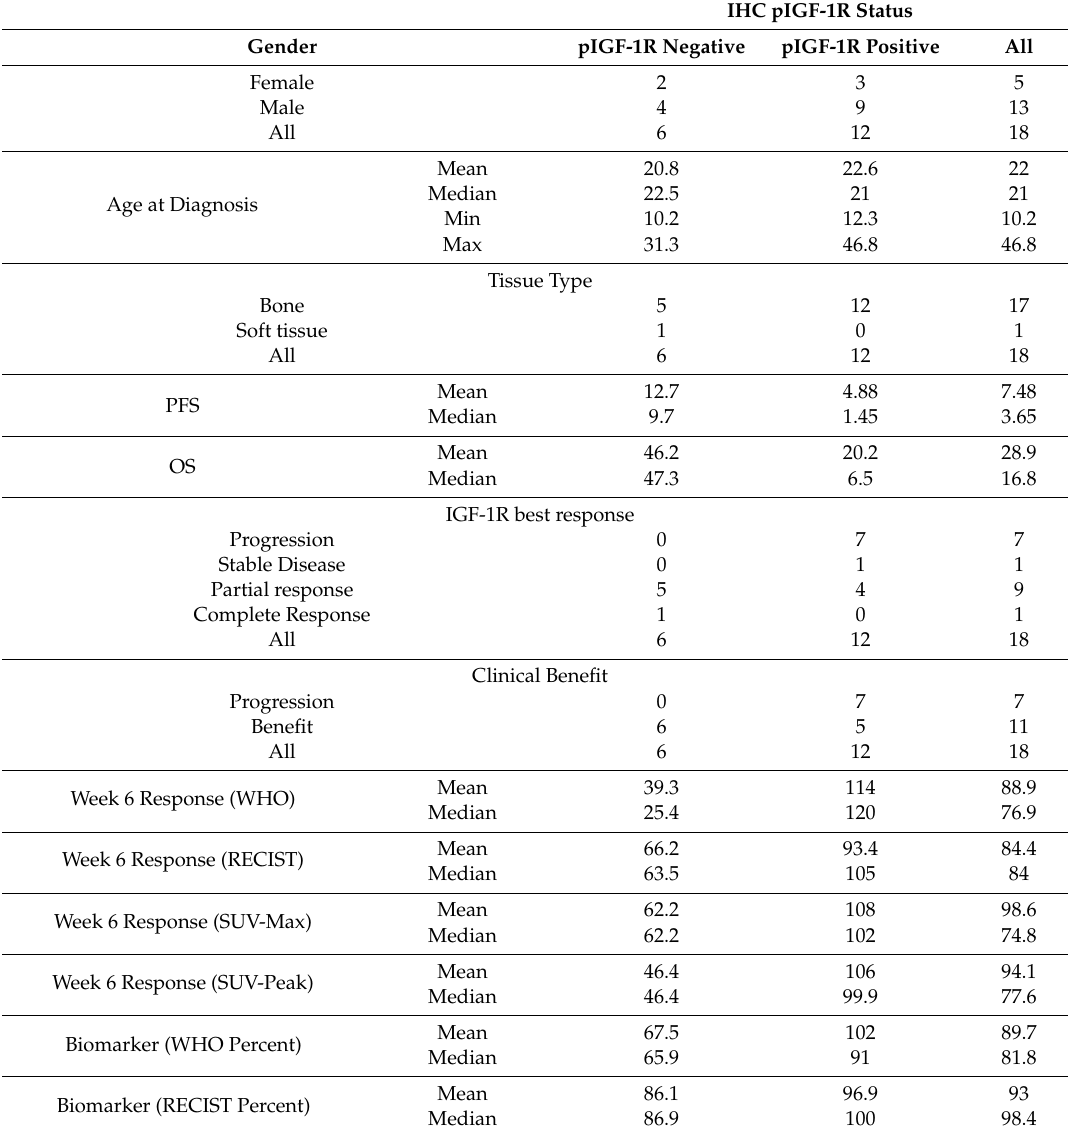
Table 3. Demographic and outcomes data, grouped by pre-treatment expression of pIGF-1R, as assessed by